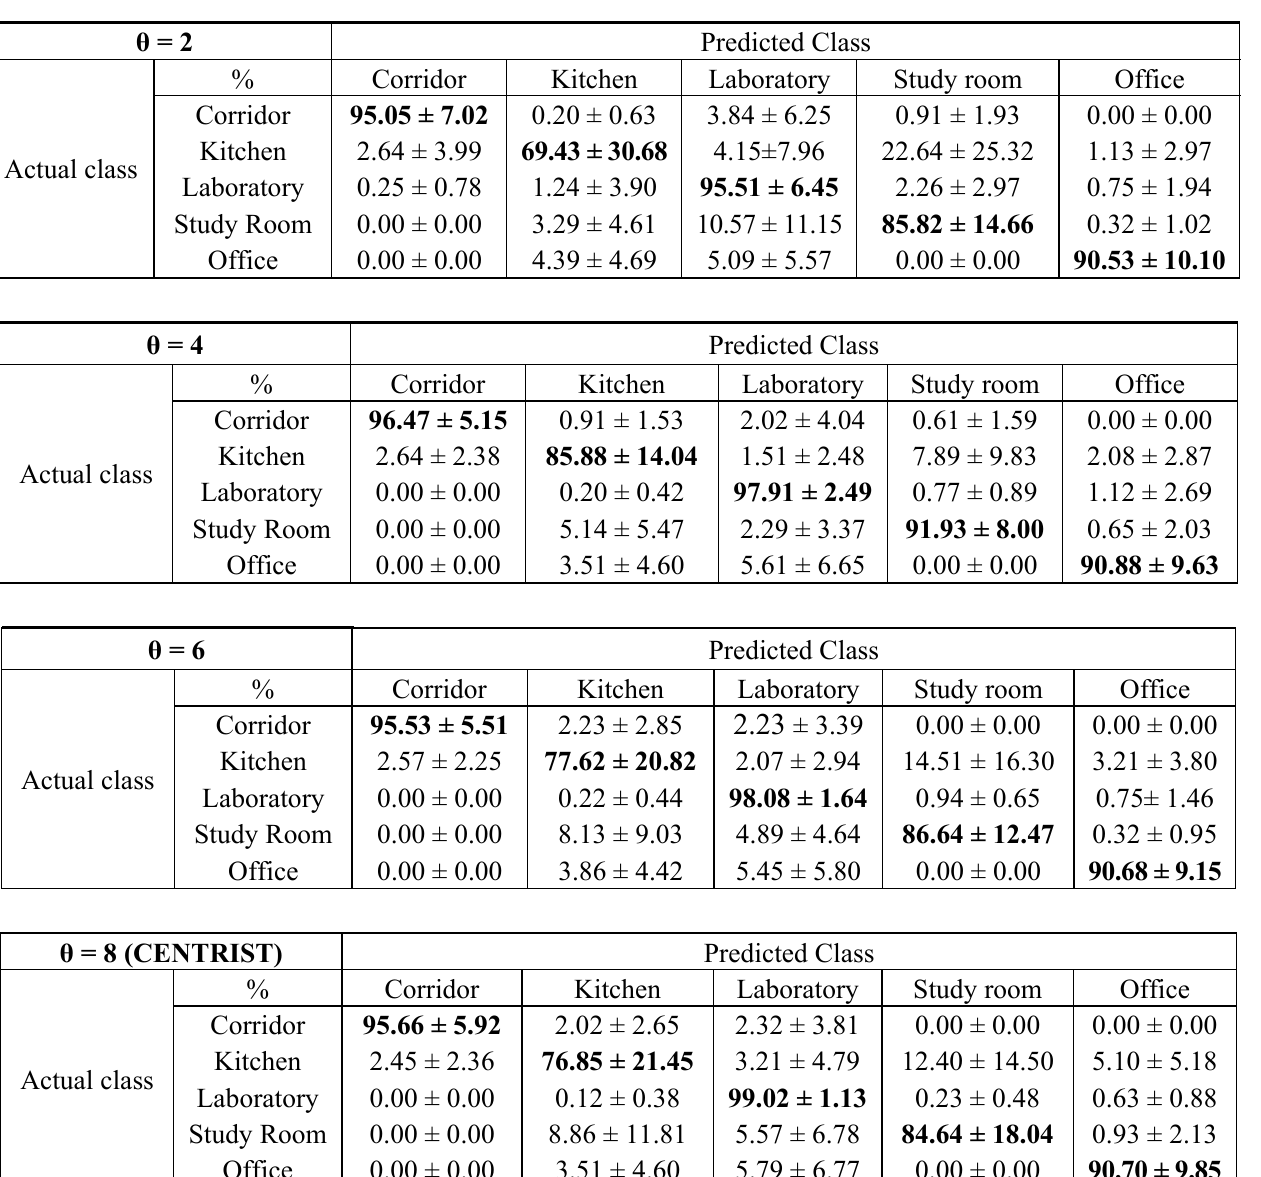
Table 3. Confusion matrices for place categorization using SVMs and different uniformity